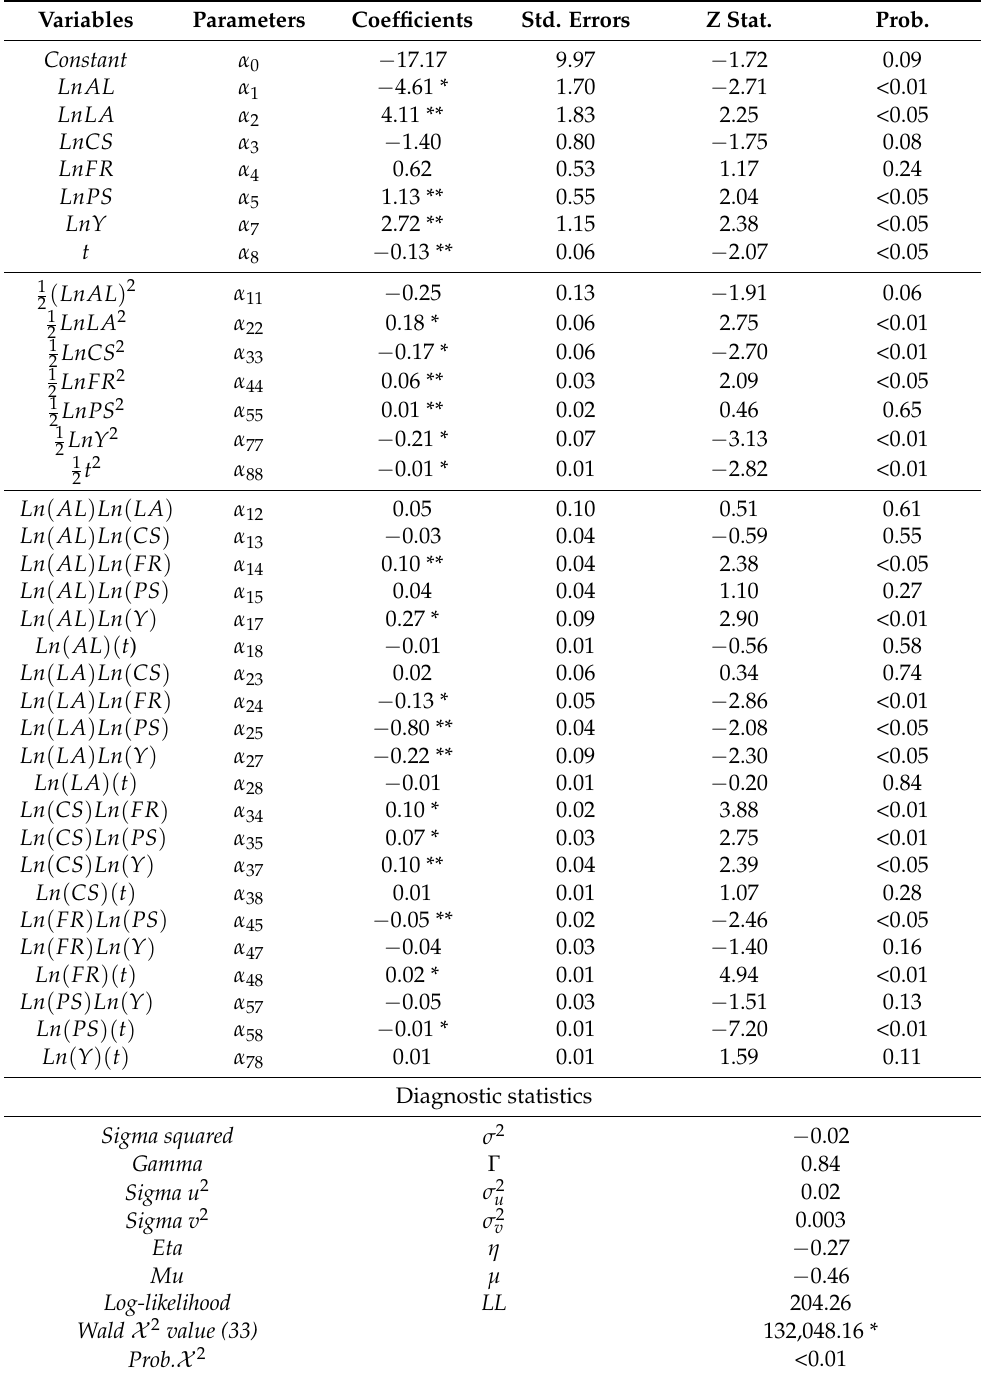
Table 4. Results of ML time-varying efficiency decay